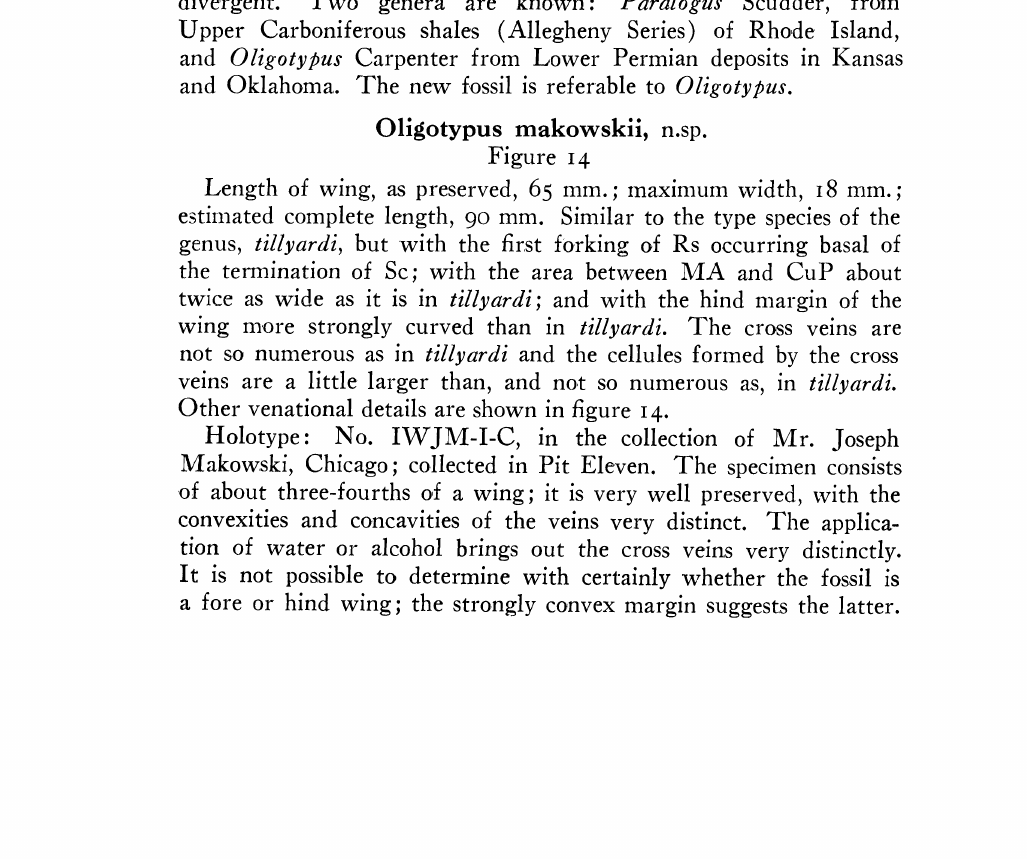
Figure 14. OligotyIus makoskii, n.sp. Drawing of holotype, No. IWJM-I-C, Makowski collection. Length of wing as preserved, 65